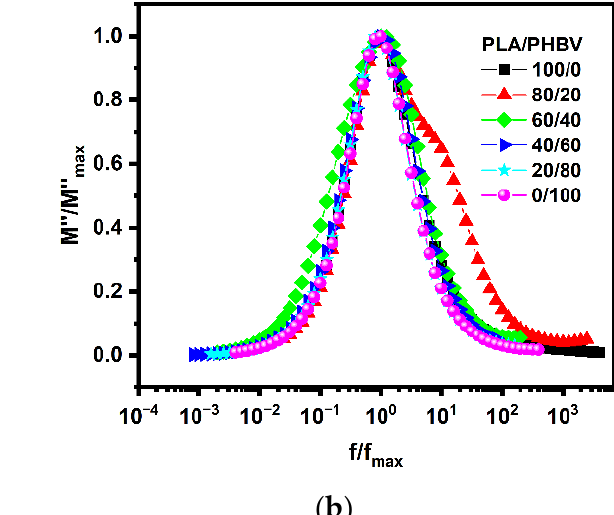
Figure 16. Dielectric loss modulus M″ as a function of frequency in the temperature range of 185 to 150 °C for ( a ) pure PLA; ( b ) PLA/PHBV (80/20); ( c ) PLA/PHBV (60/40); ( d ) Pure PHBV; ( e ) PLA/PHBV (20/80); ( f ) PLA/PHBV (40/60).